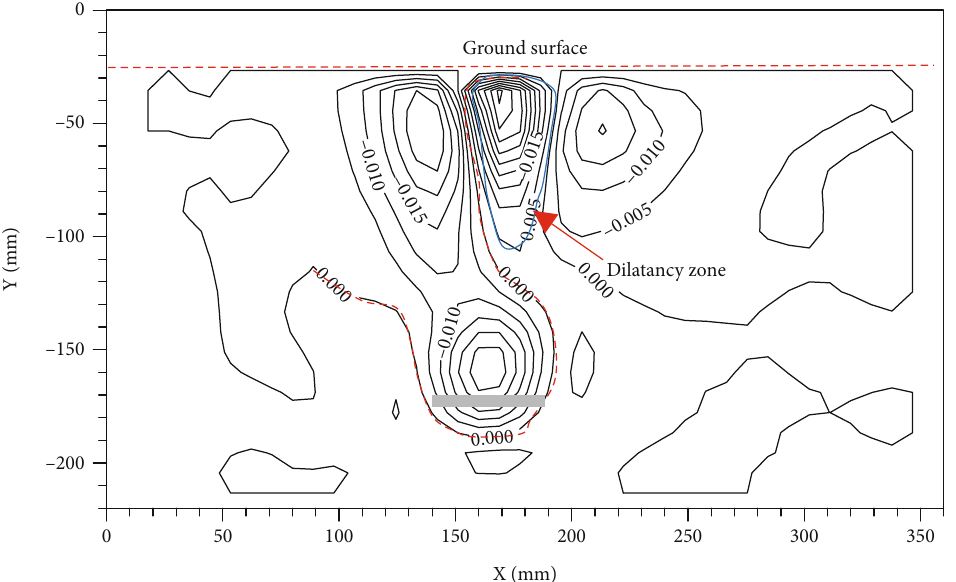
Figure 7: Volume strain fi eld at the ultimate load for D